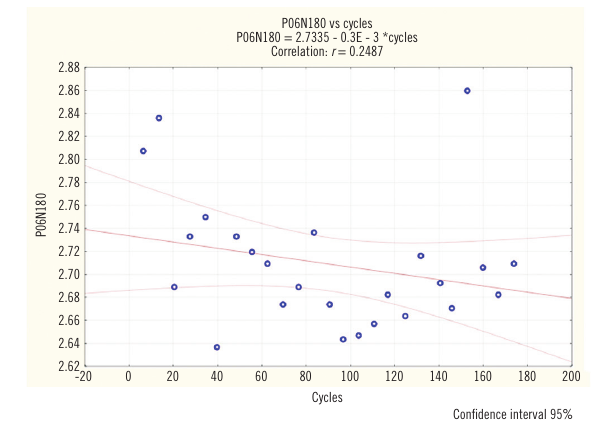
figurE 4 − Linear regression of the IQC anti-treponemal P06N180 batch based on 174 cycles of F/T IQC: internal quality control; F/T: freeze/thaw.